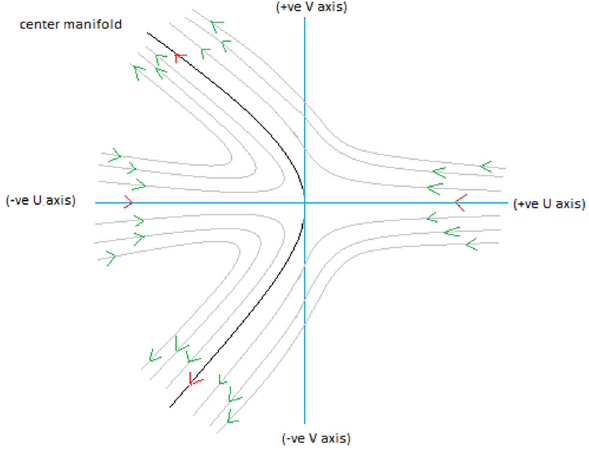
Fig. 2 Vector field near the origin for the critical point P 1 in UV -plane ( μ <